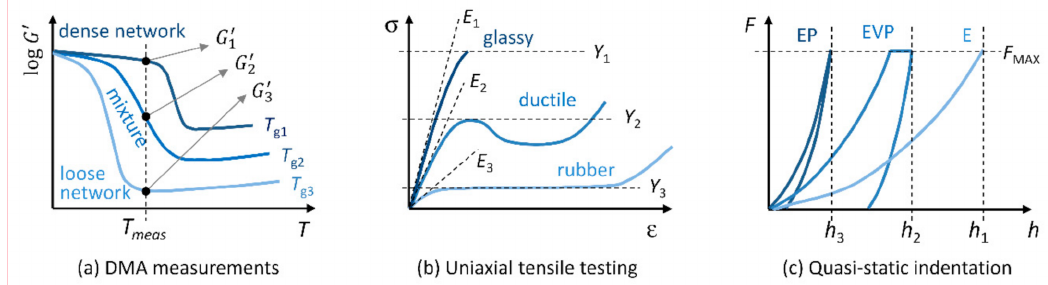
Figure 3. The scheme showing how the change of crosslinking density influences properties of crosslinked polymers measured by ( a ) DMA, ( b ) uniaxial tensile testing and ( c ) quasi-static indentation. The polymer with the highest crosslinking density (and the highest T g ) is marked with the darkest blue color, the polymer with the lowest crosslinking density (and the lowest T g ) is marked with the lightest blue color, and the mixture of the two polymers (with intermediate T g ) is marked with medium blue